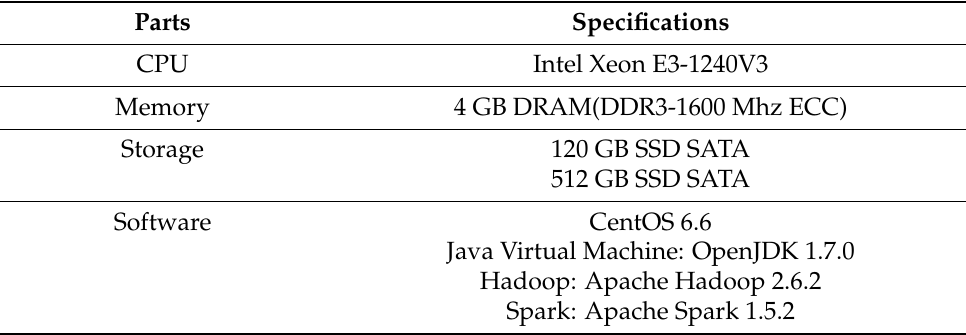
Table 2. H/W and S/W configurations of a datanode.